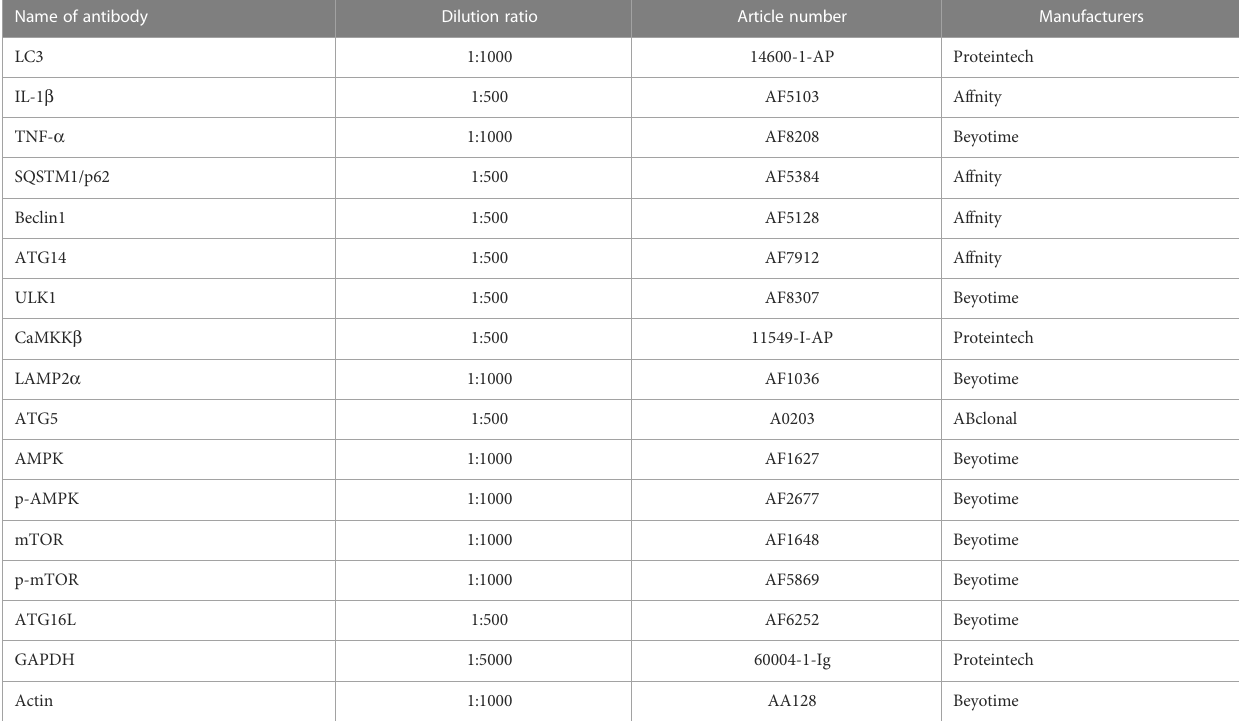
TABLE 3 Antibody information for Western blot